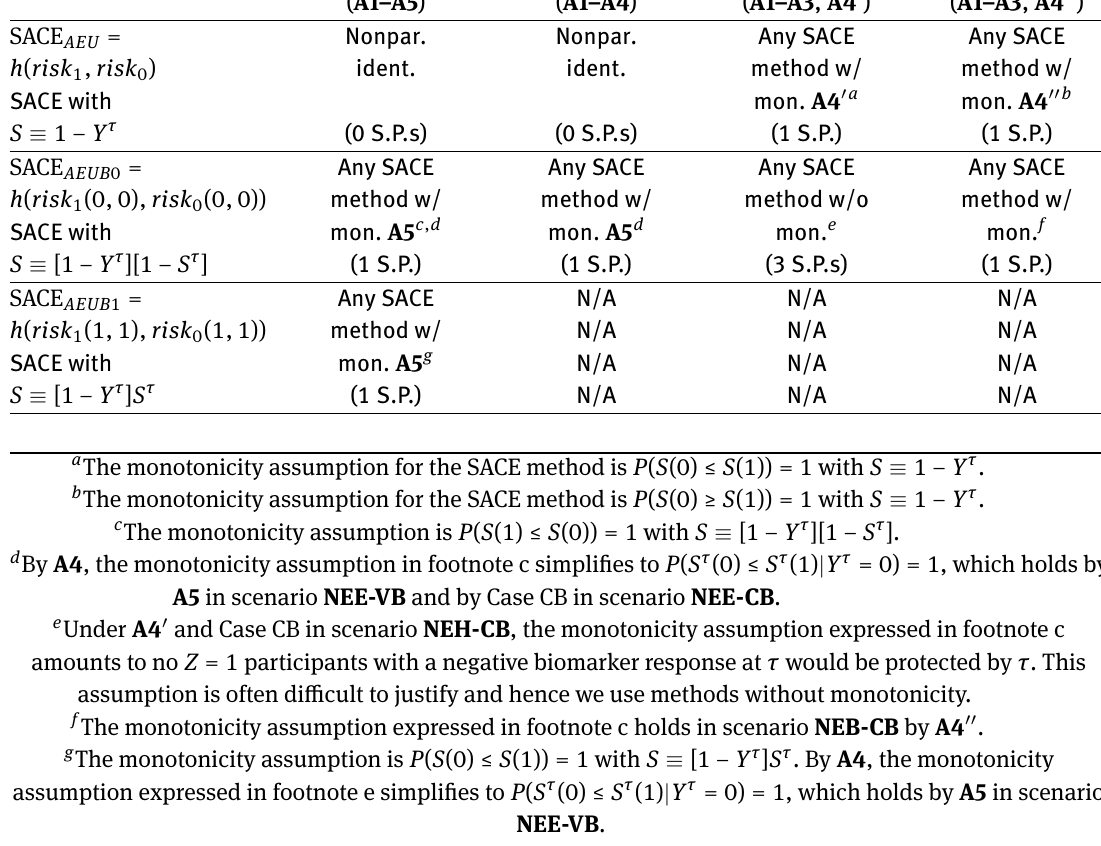
Assumption Sets (Identifiability